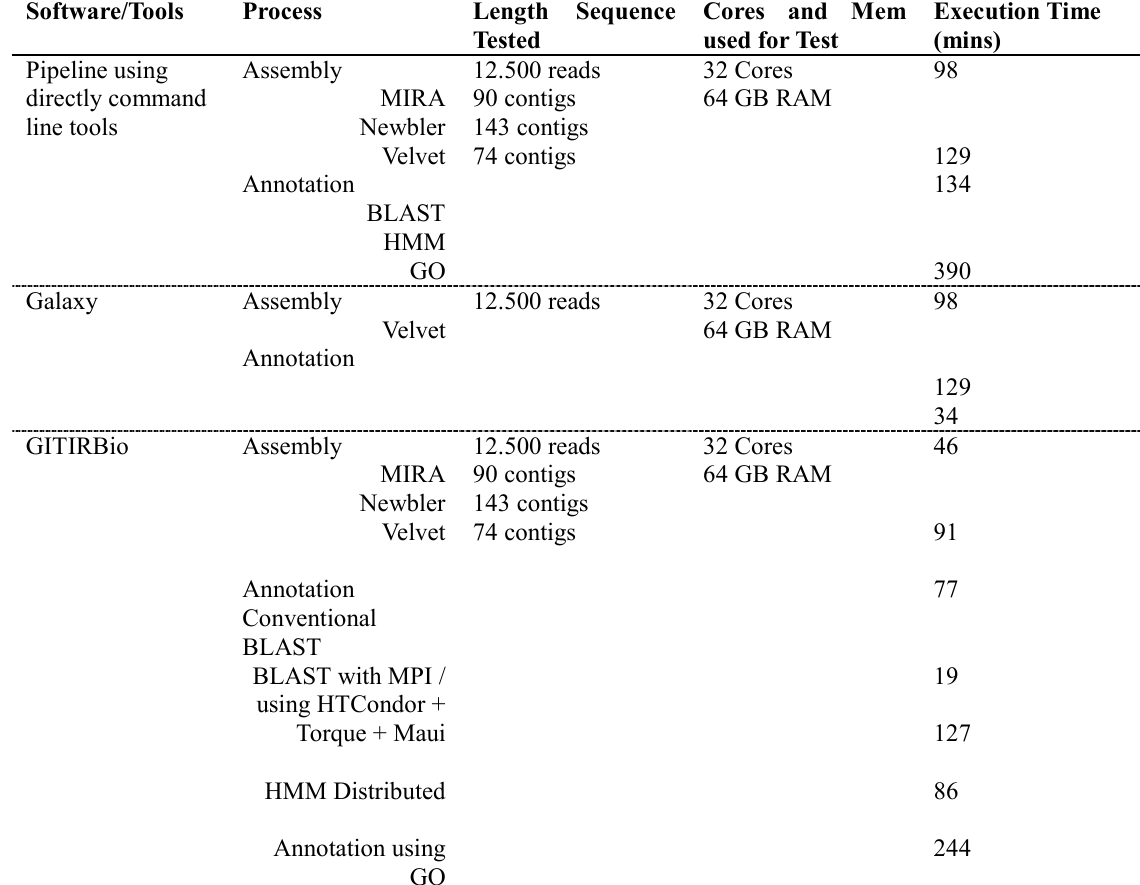
Table 1: Performance using